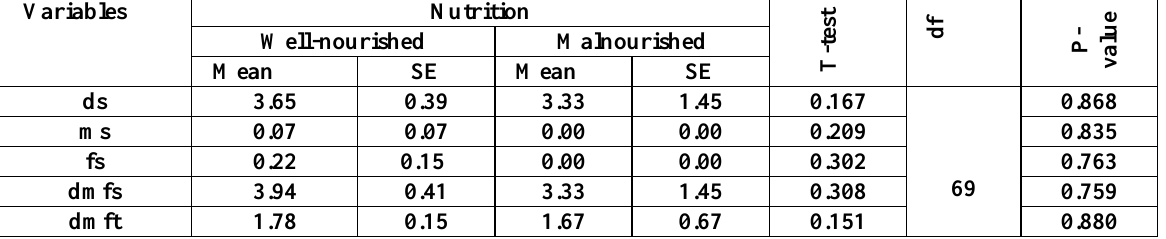
Table 6: Caries experience of the primary teeth (mean and standard errors) among students by nutritional status.